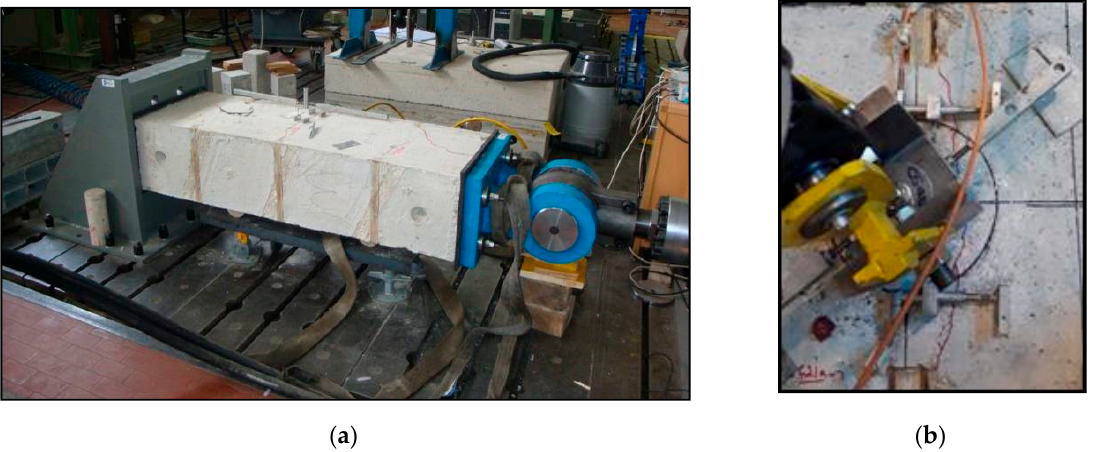
Figure 5. Test apparatus for test in cracked concrete: ( a ) general view; and ( b ) details at the anchor location. LVDTs (range: 0–10 mm) were used to monitor the crack opening on both sides of the anchor during testing (Figure 5b).